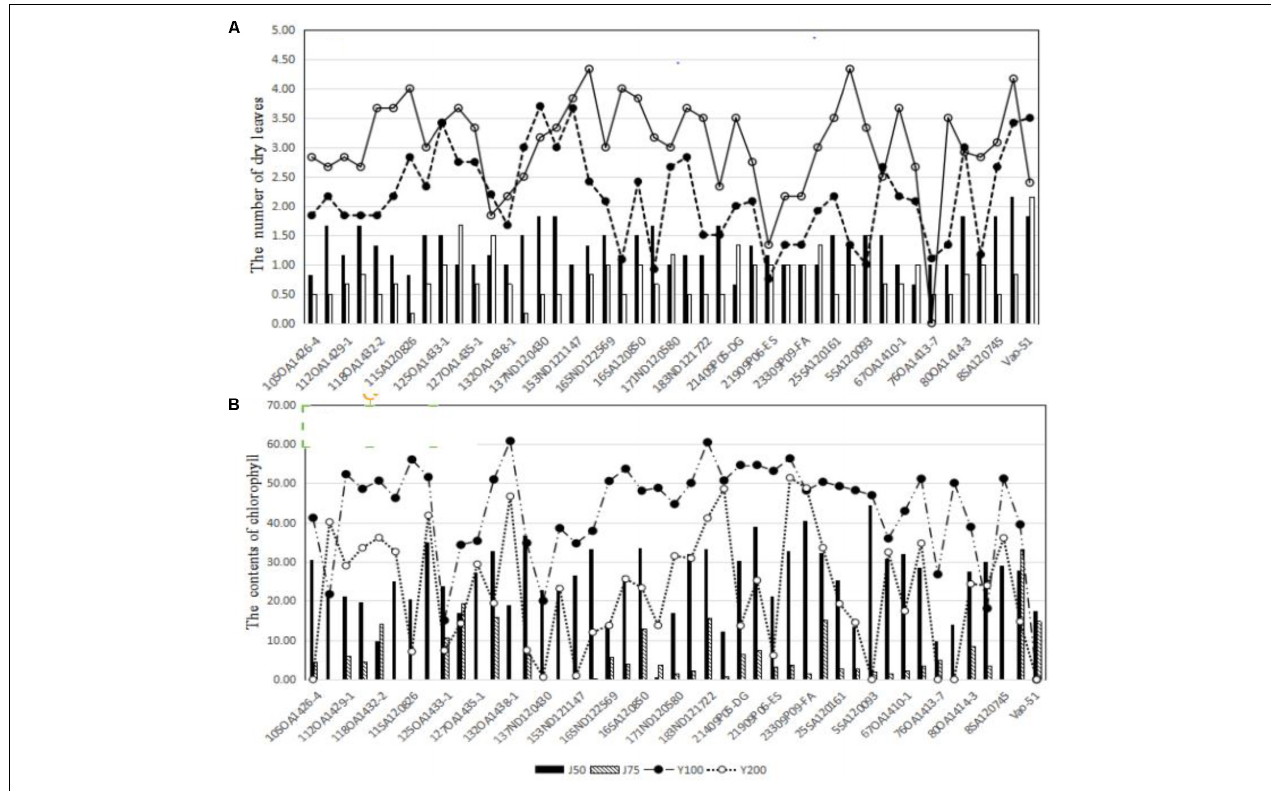
FIGURE 8 | (A) The effects of salt and alkali stresses on the number of dry leaves for 43 oat genotypes. (B) The effects of salt and alkali stresses on chlorophyll contents for 43 oat genotypes. J50, 50 mmol L − 1 alkali stress; J75, 75 mmol L − 1 alkali stress; Y100, 100 mmol L − 1 salt stress; Y200, 200 mmol L − 1 salt stress.